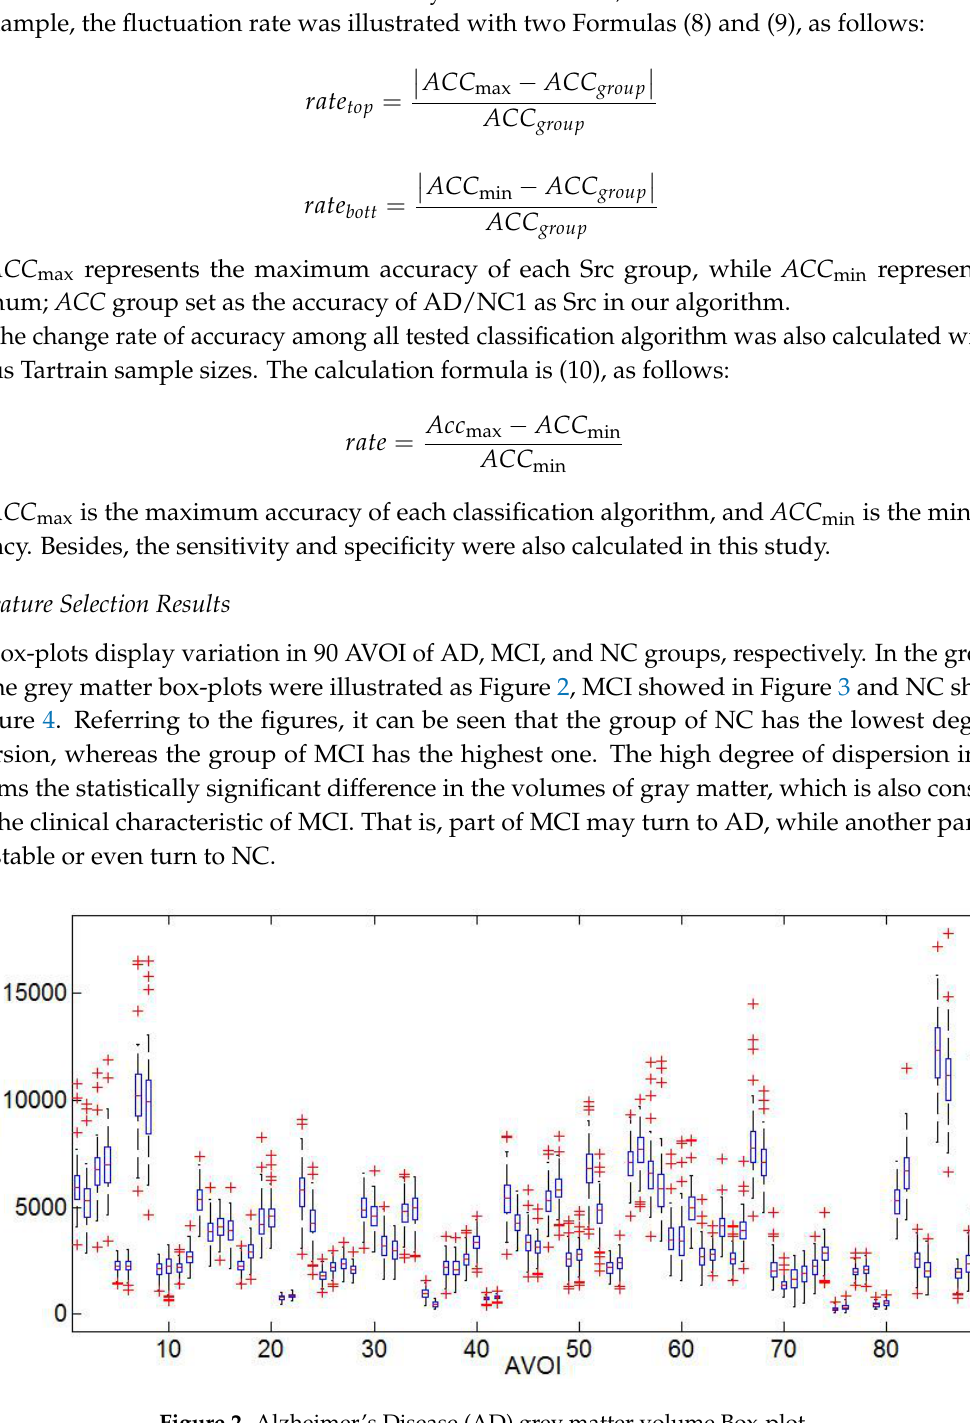
Figure 2. Alzheimer’s Disease (AD) grey matter volume Box-plot.